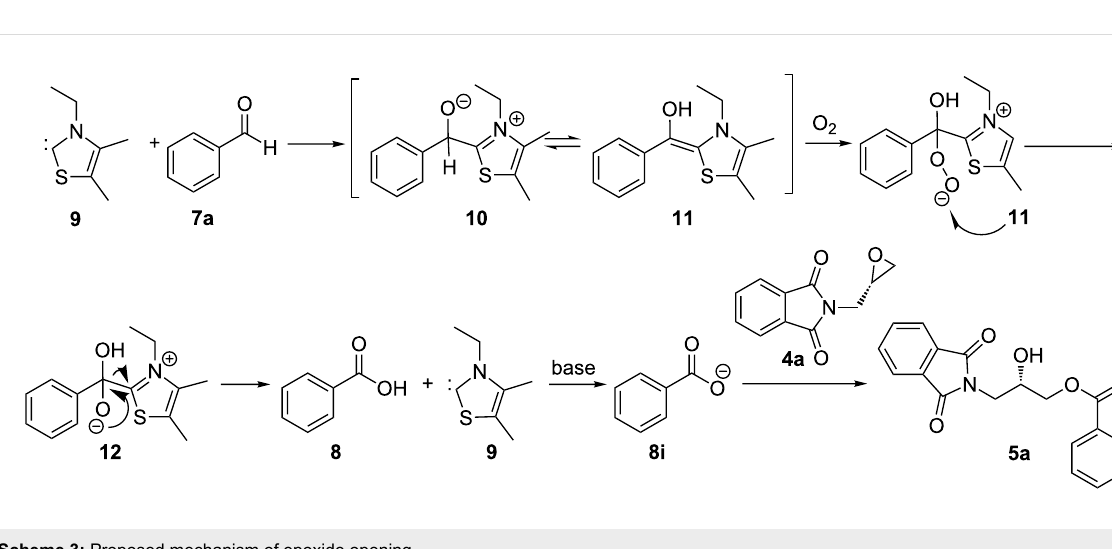
Scheme 3: Proposed mechanism of epoxide